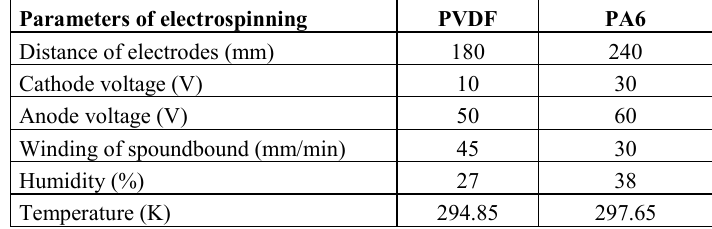
Table. 1. Parameters of electrospinning on the NS 1WS500U device. Parameters of